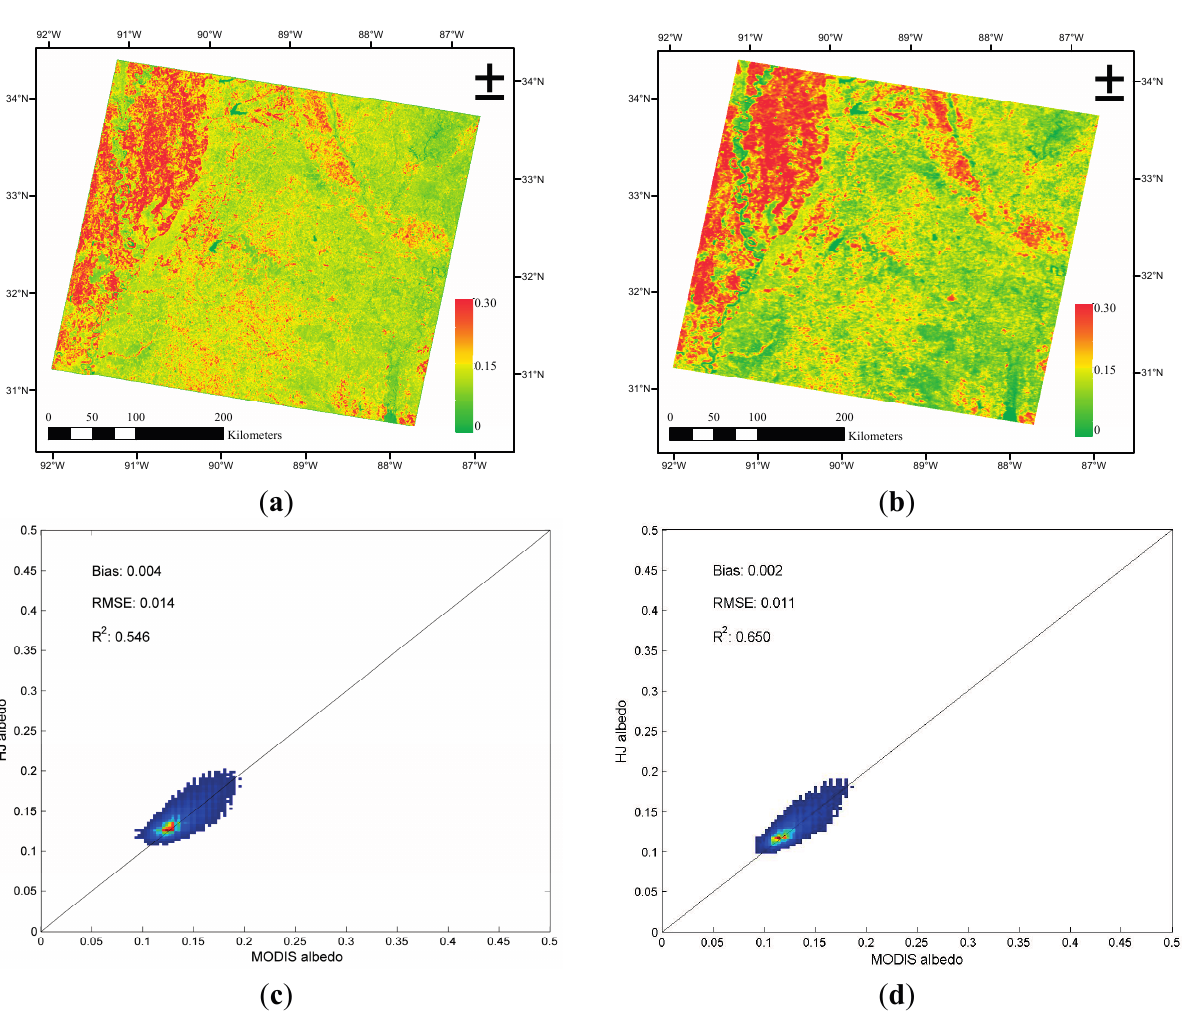
Figure 8. White-sky albedo maps from ( a ) HJ data and ( b ) MODIS 500 m albedo product; Scatter plots (density plot: low density in blue and high density in red) between HJ albedo and MODIS product for ( c ) white-sky albedo and ( d ) black-sky albedo in Mississippi, USA on 23 September 2014. Some water bodies are masked in white in the MODIS